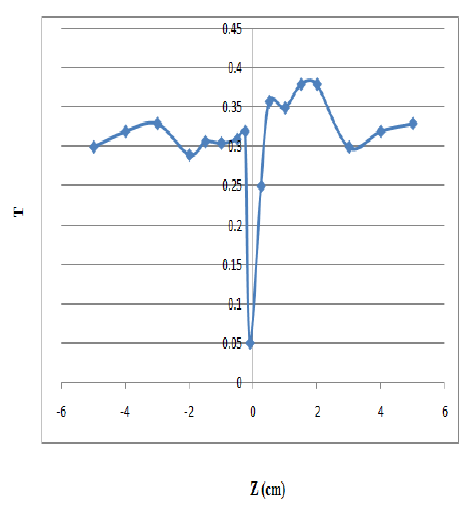
Fig.9: Open-aperture Z-Scan at 532